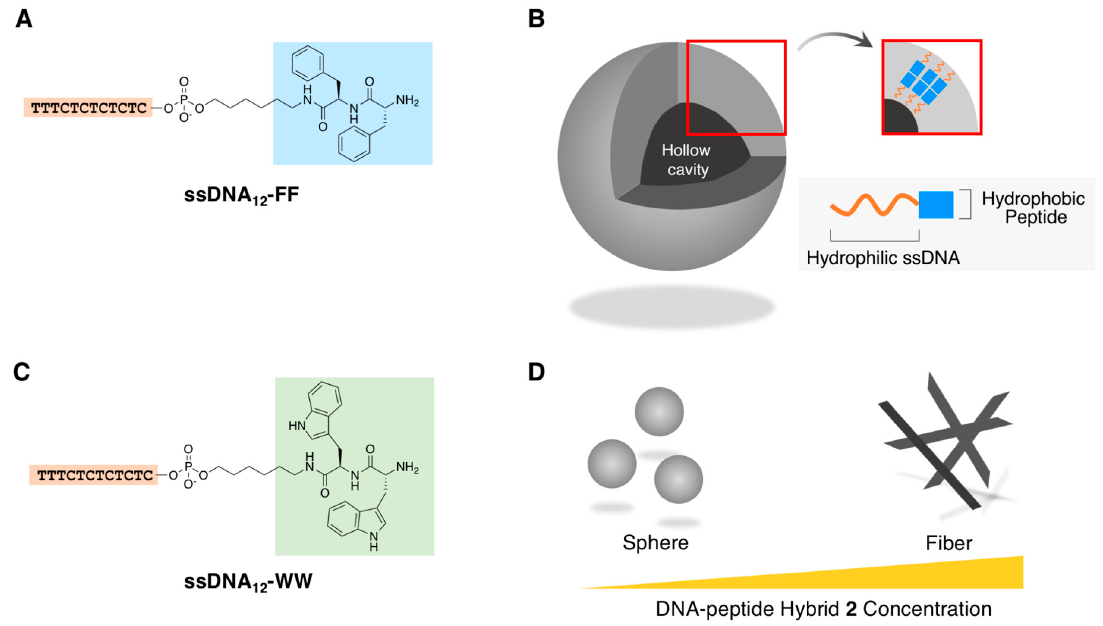
Figure 10. ( A ) Chemical structure of ssDNA 12 -FF . ( B ) Plausible supramolecular architectures of the hollow vesicular structures that were obtained through the self-assembly of ssDNA 12 -FF . ( C ) Chemical structure of ssDNA 12 -WW . ( D ) Plausible, concentration-dependent supramolecular architectures of ssDNA 12 -WW obtained by its self-assembly. Adapted from [91,92]. Copyright 2012 and 2014 Royal Chemical Society.